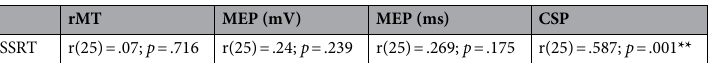
Table 2. Correlations between the TMS-derived neurophysiological parameters and SSRT. Values in the table represent Pearson correlation coefficient and significance of the Pearson correlations between each significant TMS-derived Neurophysiological parameter and the SSRT. Legend: rMT = Resting Motor Threshold; MEP (mV) = Motor Evoked Potential amplitude; MEP (ms) Motor Evoked Potential duration; CSP = Cortical Silent Period (absolute); SSRT = see Table 1; ** = correlation is significant at the 0.01 level